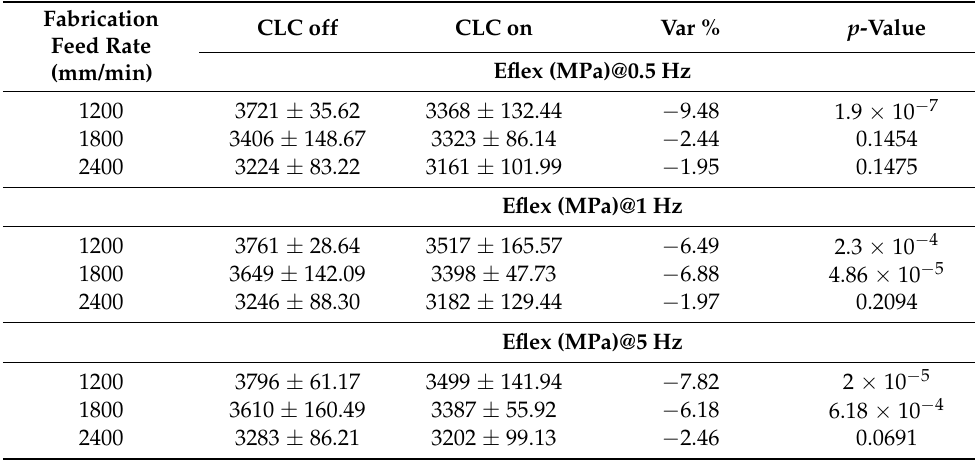
Table 9. Numerical results obtained from dynamic mechanical analysis.